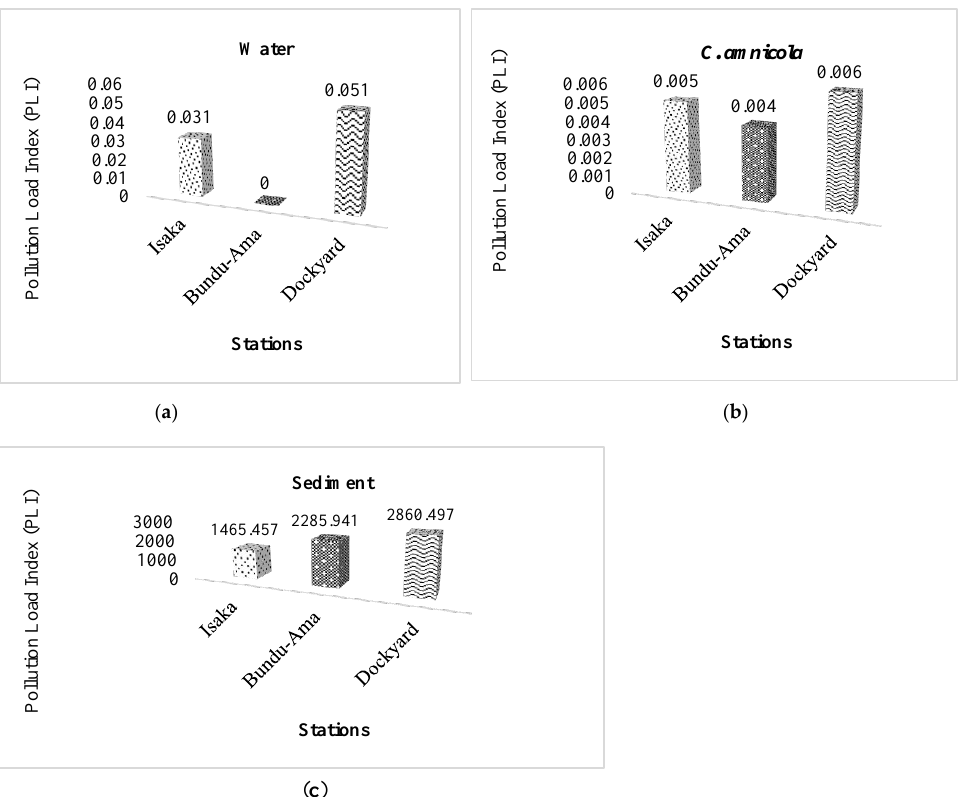
Table 5. Toxic metal geo-accumulation index (Igeo) and pollution load index (PLI) in the Isaka– Bundu tidal mangrove swamp. Isaka